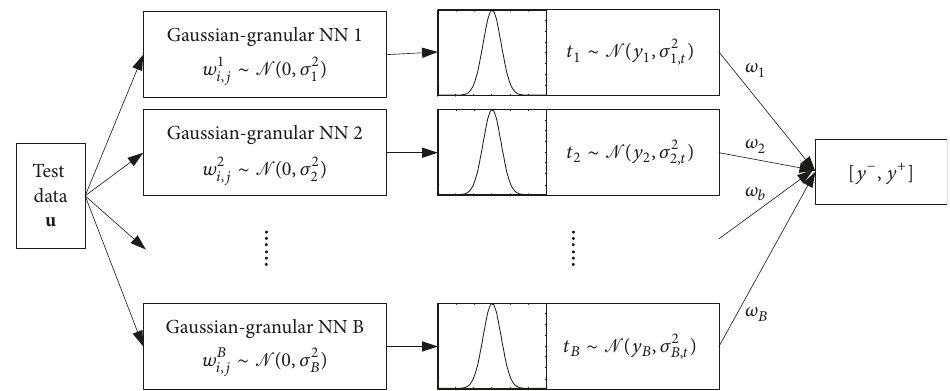
Figure 1: Architecture of the distributed